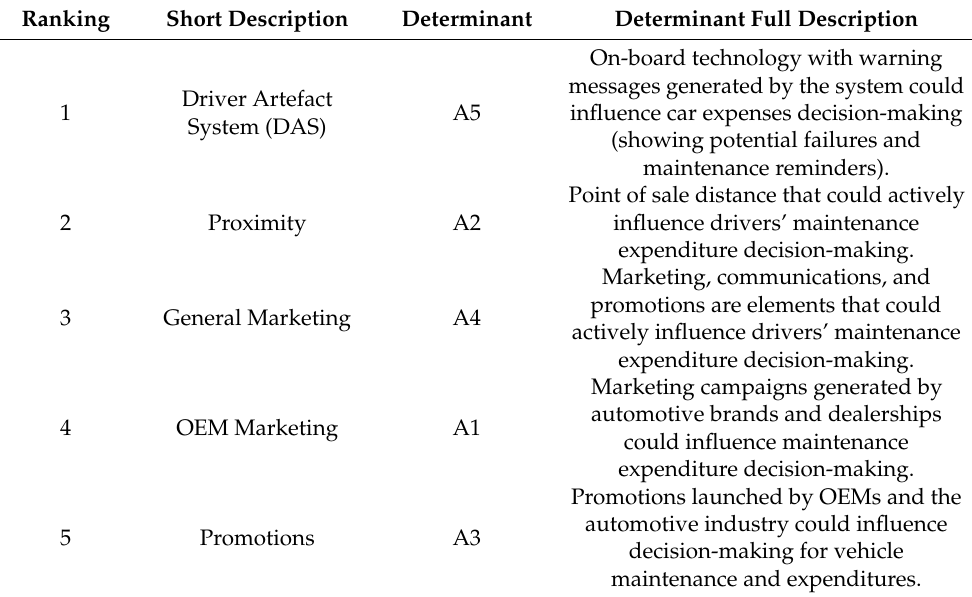
Table 4. Final Delphi method ranking with the most popular